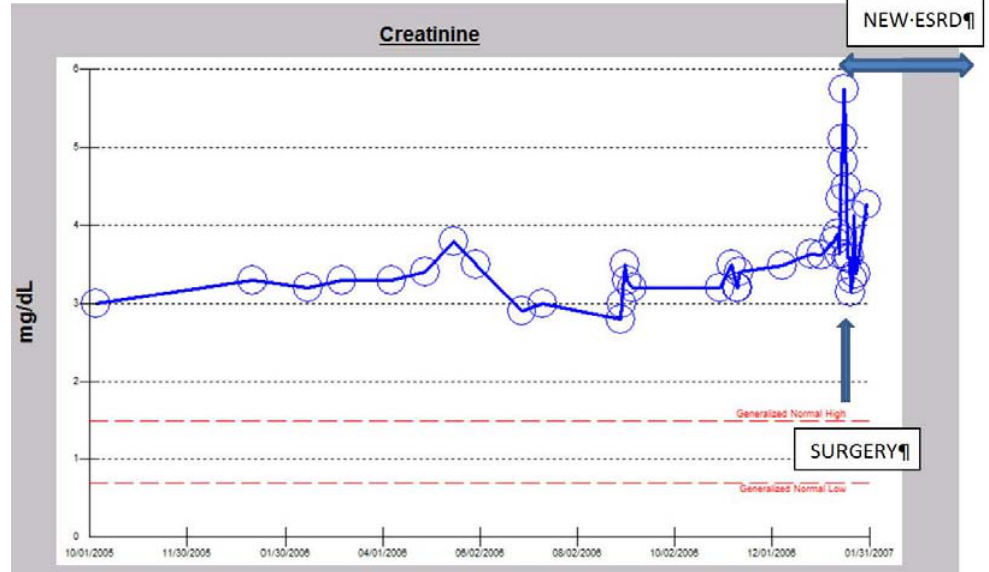
Figure 9. Serum creatinine trajectory in the diabetic, hypertensive Caucasian male patient with features of LORFFAB following initial recovery of renal function and hemodialysis independence before the second post-operative hemodialysis-requiring AKI-ESRD in January